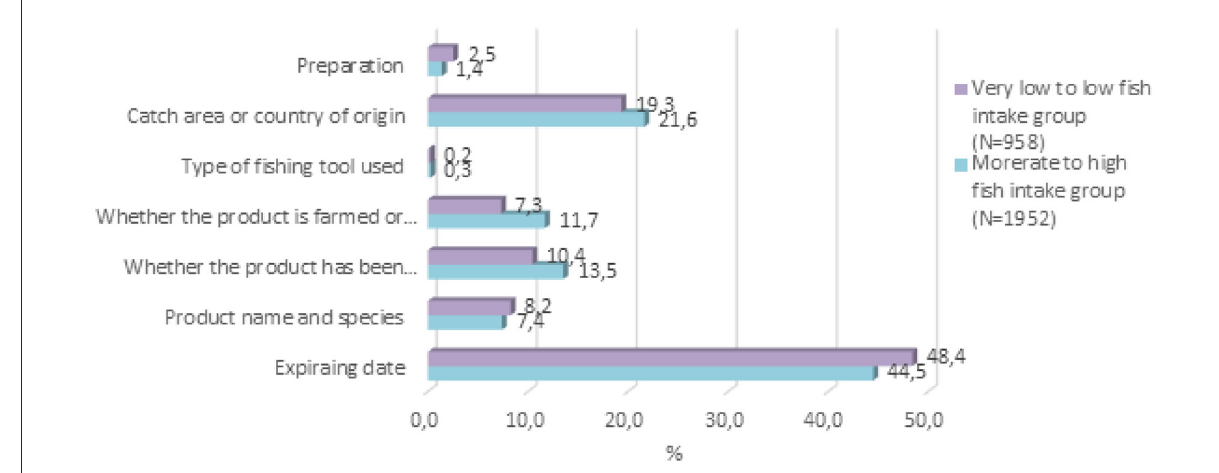
FIGURE3 The most relevant information on fishery products among groups regarding recommended fish intake.